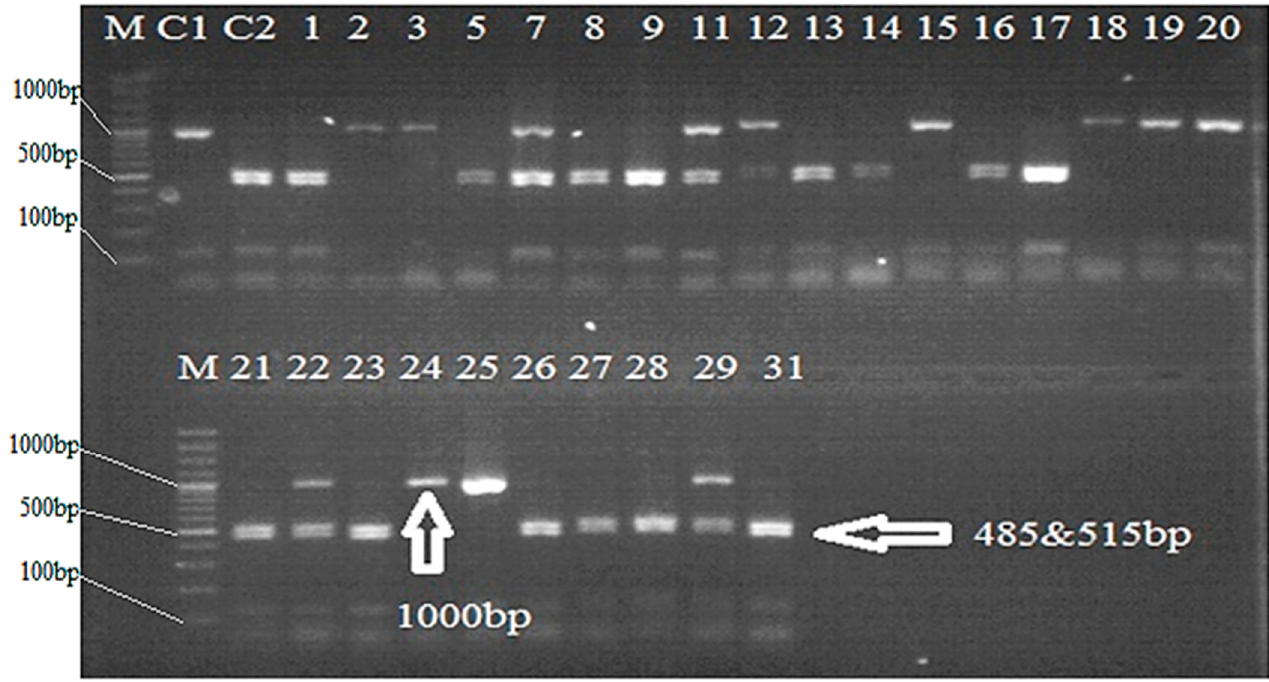
Figure 2. PCR analysis of RILs of rice for the presence of xa13 gene (Arrow showing 485 and 515 bp bands of xa 13 gene). M = 100 bp DNA ladder, C1 = Basmati-385, C2 = IRBB59, line 1–31 = Selected genotypes.